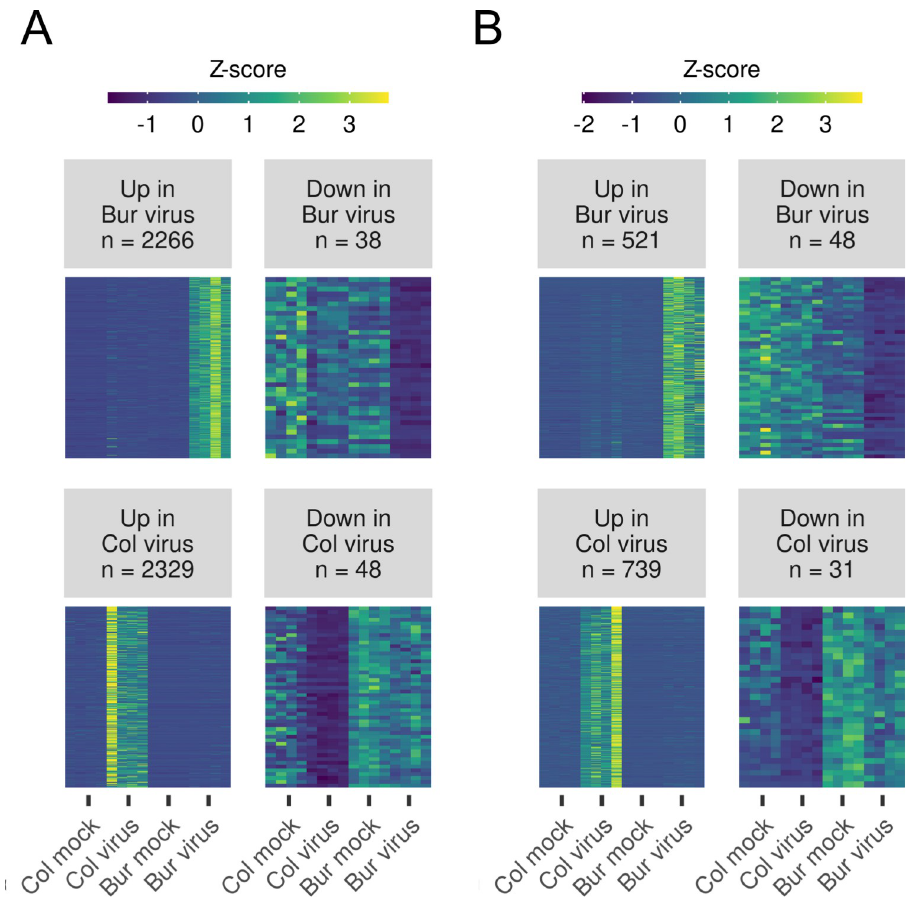
Fig 8. Expression pattern of the differentially expressed sRNA sequences between Bur and Col plants infected either with TVCV or TuMV. To get a list of differentially expressed sRNAs (DESs) that significantly change only in the Bur (or Col) virus-infected samples, a Wald-test was applied (i.e., Bur virus samples against all the others). Only sequences with padj < 0.05, Log2FoldChange > log(1.5), and baseMean (mean raw expression level) > 0 were accepted as DESs. The number of DESs is noted in the title. Normalized expression values of the individual, differentially expressed sequences in (A) TVCV and (B) TuMV-infected samples were centered by calculating Z -scores. Z -score tells how many Standard Deviations an expression value is from the mean expression of an individual sequence. In this way, sequences with different mean expression levels can be compared. The expressions of DESs in samples are represented in a heatmap. The expressions of the four biological replicates are shown for every